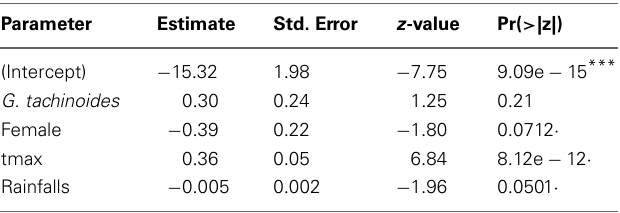
Table 1 | Fixed effects of the best prediction model for T. congolense infection rates.